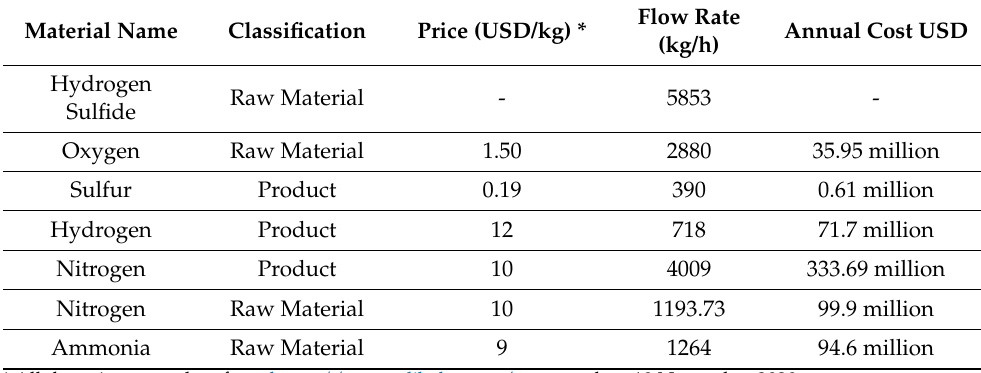
Table 11. Material of construction cost